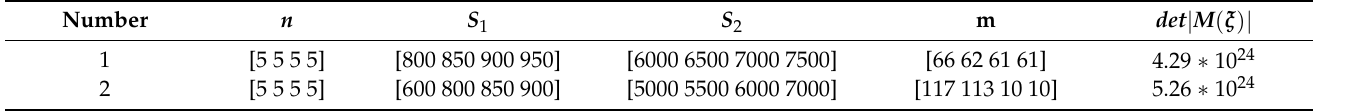
Table 14. D -optimality optimal